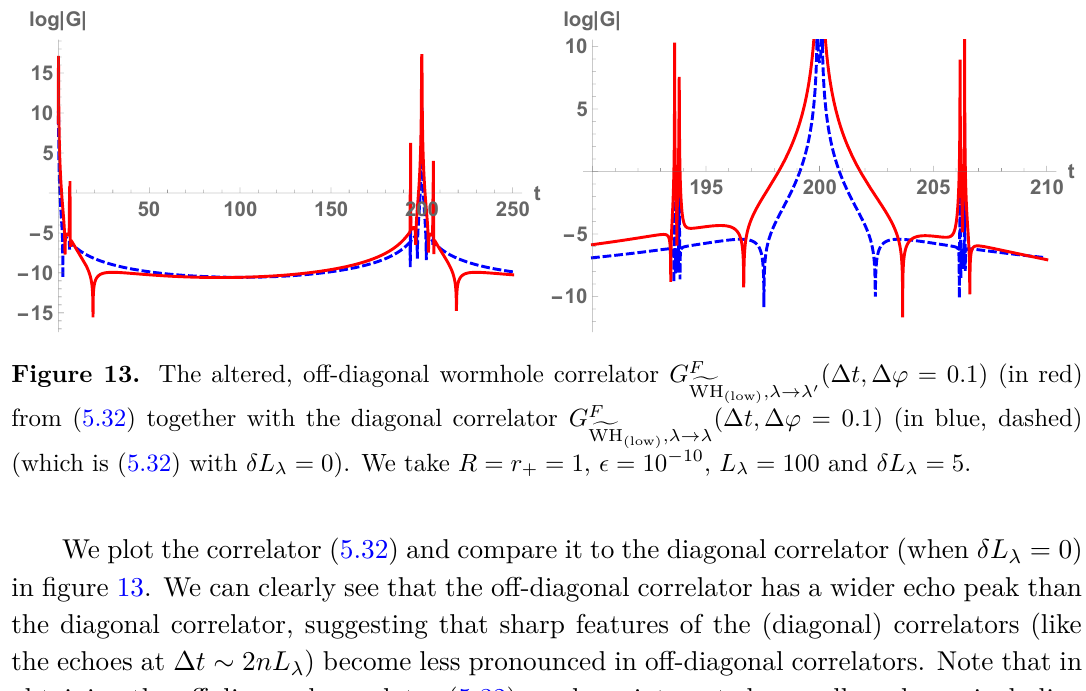
We plot the correlator (5.32) and compare it to the diagonal correlator (when δL = 0 ) λ in figure 13. We can clearly see that the off-diagonal correlator has a wider echo peak than the diagonal correlator, suggesting that sharp features of the (diagonal) correlators (like the echoes at ∆ t ∼ 2 nL ) become less pronounced in off-diagonal correlators. Note that in λ obtaining the off-diagonal correlator (5.32), we have integrated over all modes ω , including those that do not satisfy ω (cid:28) ( δL ) − 1 ; for such high-frequency modes, it can easily be λ seen that the expansion (3.45) (with κ replaced by ˜ κ (low) ) breaks down. Therefore, the obtained correlator (and in particular any spurious short-time behaviour) should be taken with a grain of